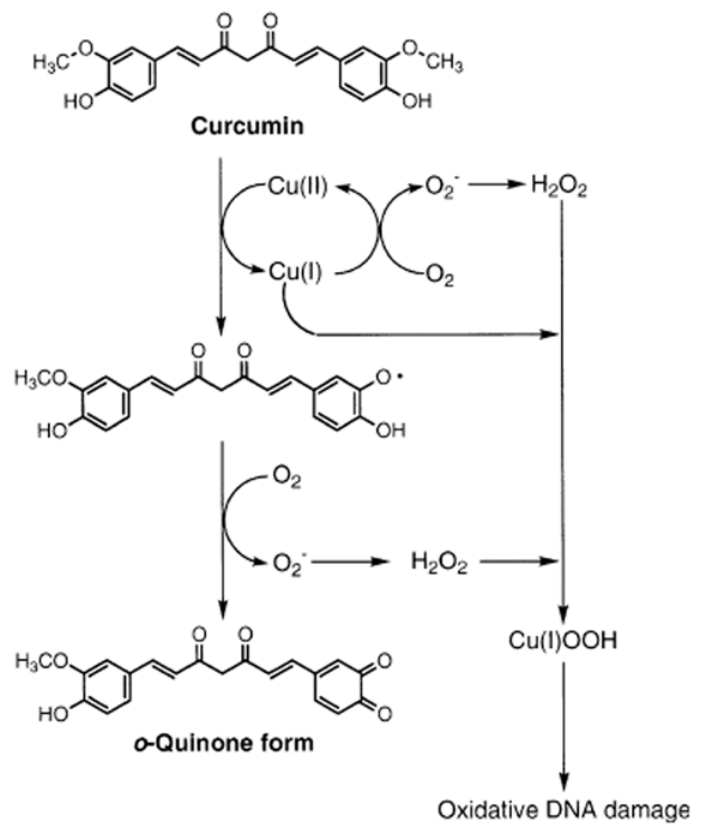
Figure 2. Proposed mechanism for curcumin–Cu (II) induced DNA